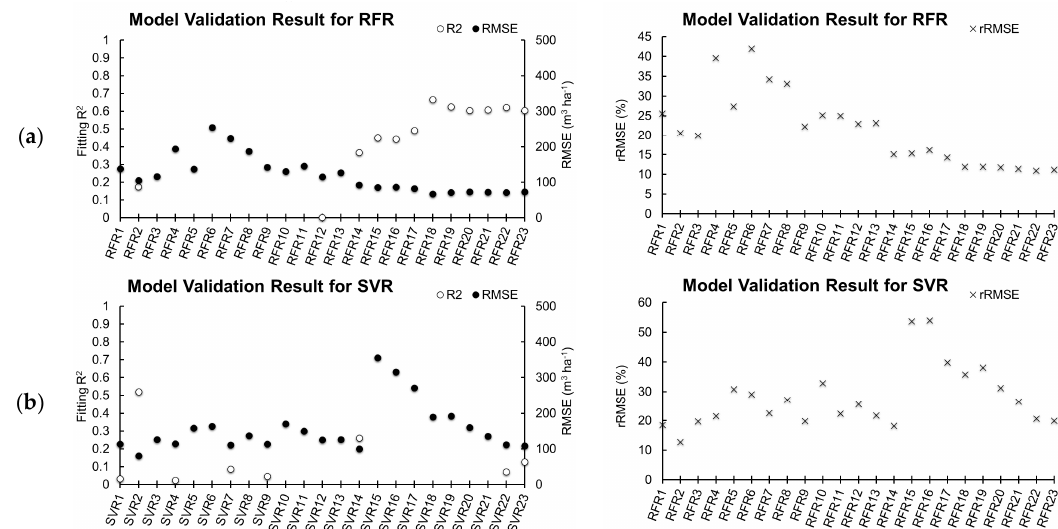
Figure 11. Summary of the results for all regression analyses tested. Each result for the correlation of determination (R 2 ), root mean square error (RMSE), and relative RMSE (rRMSE) is shown for ( a ) RFR and ( b ) SVR. Only positive R 2 is drawn and the models and without R 2 plots indicates all negative fitting R 2 , hence erroneous models.